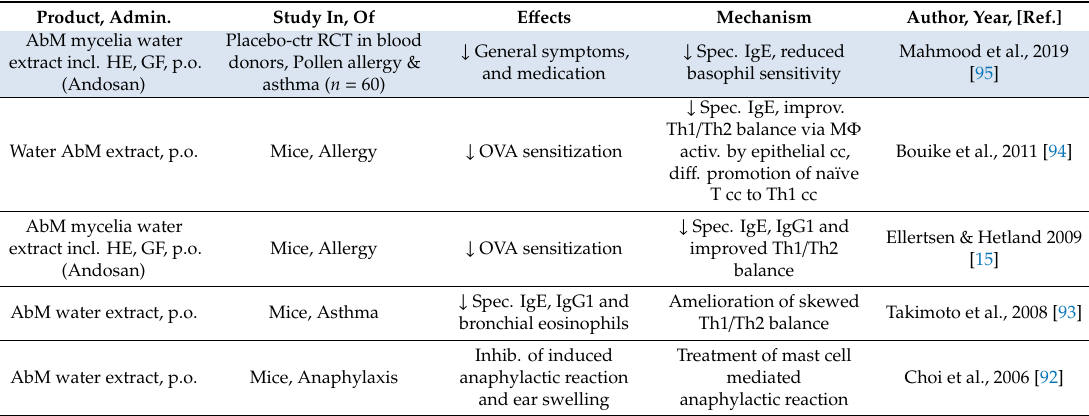
Table 6. Anti-allergic E ff ects of Agaricus blazei Murill and Grifola frondosa (Human study) . Product,